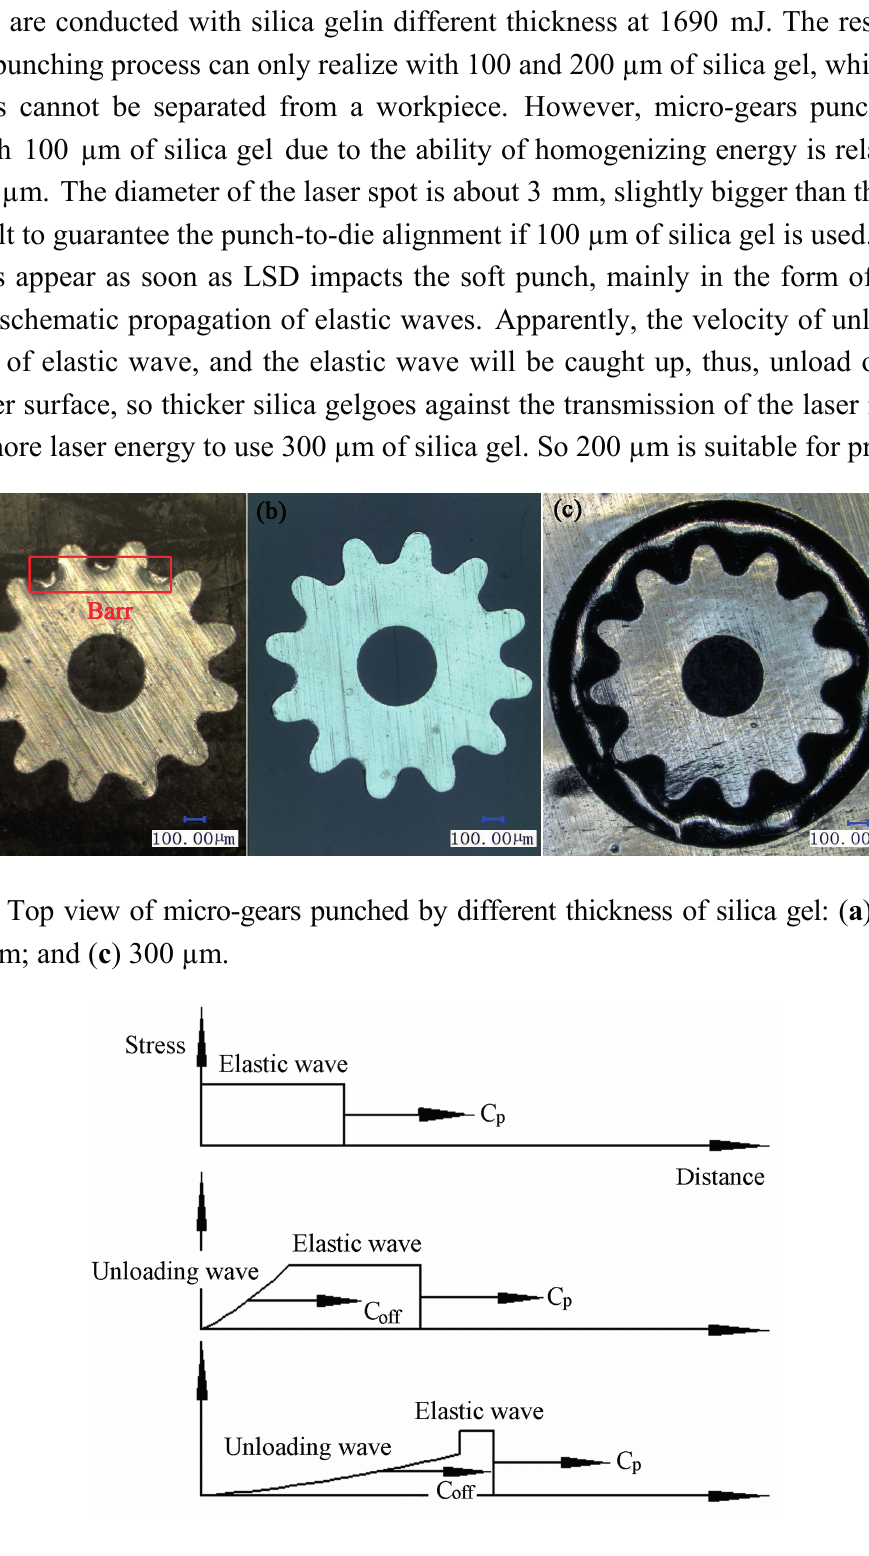
Figure 6. Schematic propagation of elastic waves: C p is the velocity of elastic wave; C off is the velocity of unloading